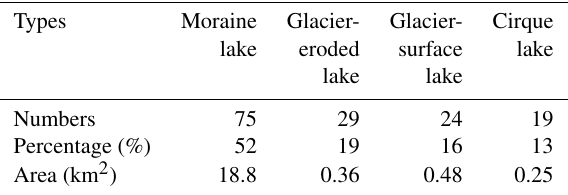
Table 5. Types of glacial lakes in the Poiqu River basin. Types Moraine Glacier-